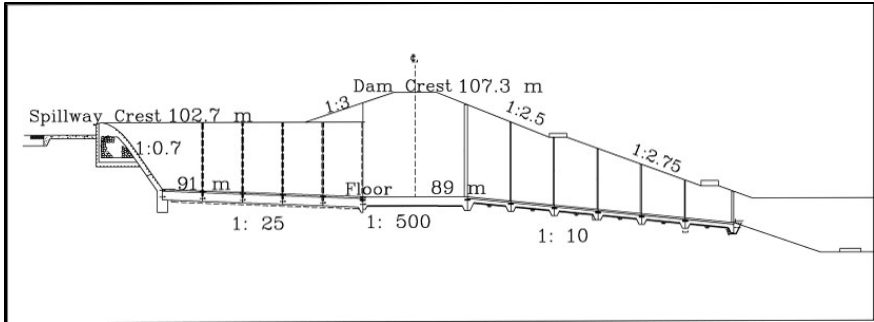
Figure 2. Longitudinal section of Swa Dam’s spillway (before collapse)